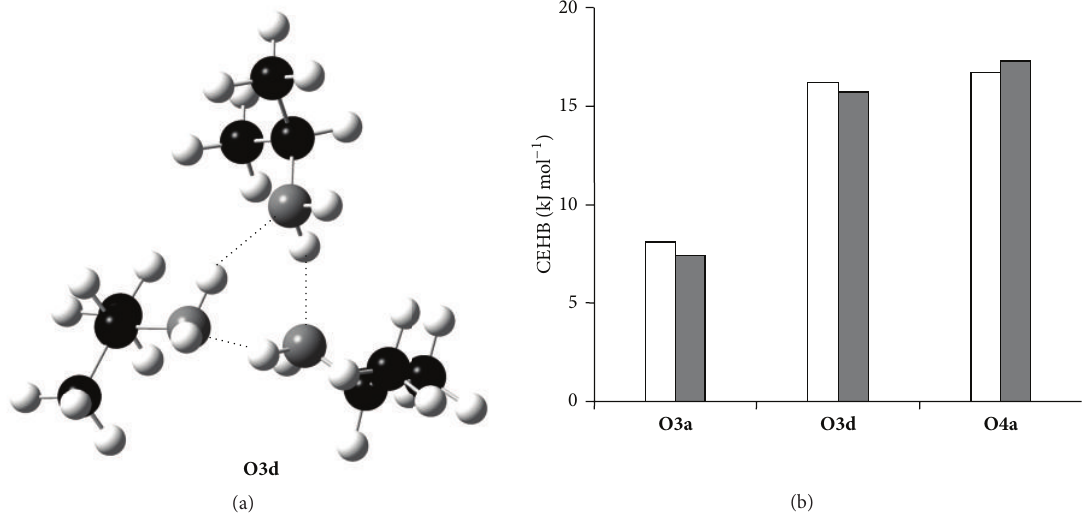
Figure 4: Comparison of the CP-uncorrected and CP-corrected CEHB values predicted by the B97D calculations for the O3d (which assembles the most stable geometry predicted for trimeric water clusters [25, 26]), O3a , and O4a iPram clusters. The overall O3d optimized geometry is also